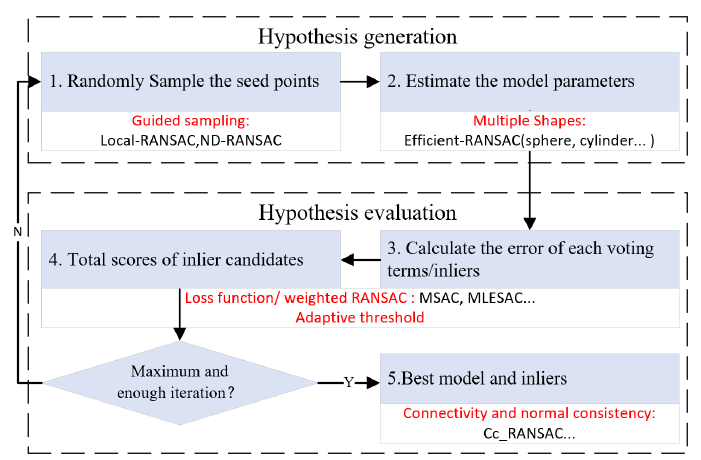
Figure 1. The workflow of RANSAC and improvements from its